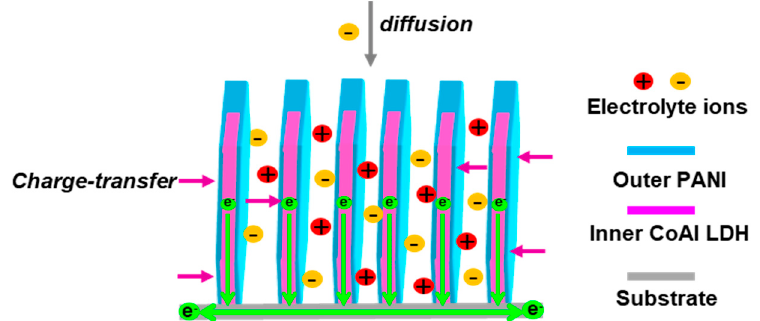
A schematic cross section illustration of electrolyte diffusion paths in CoAl LDH-PANI